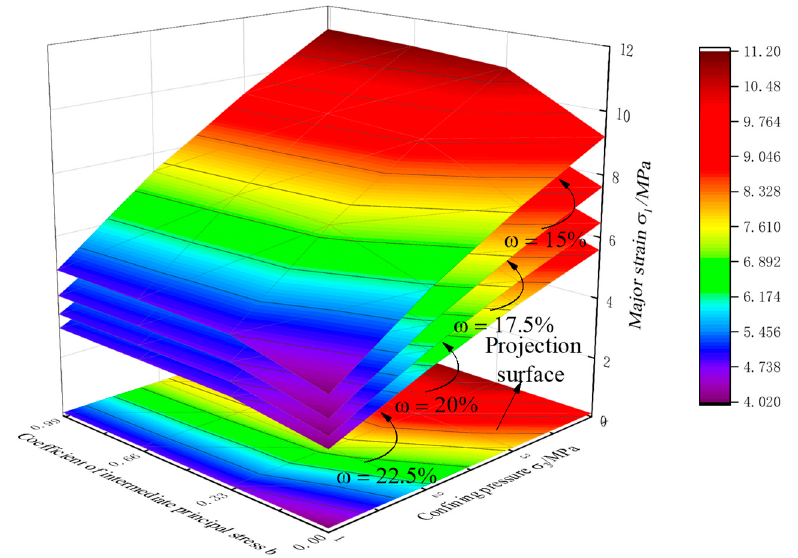
Figure 9. Three-dimensional trend chart of b value, confining pressure, and major principal stress